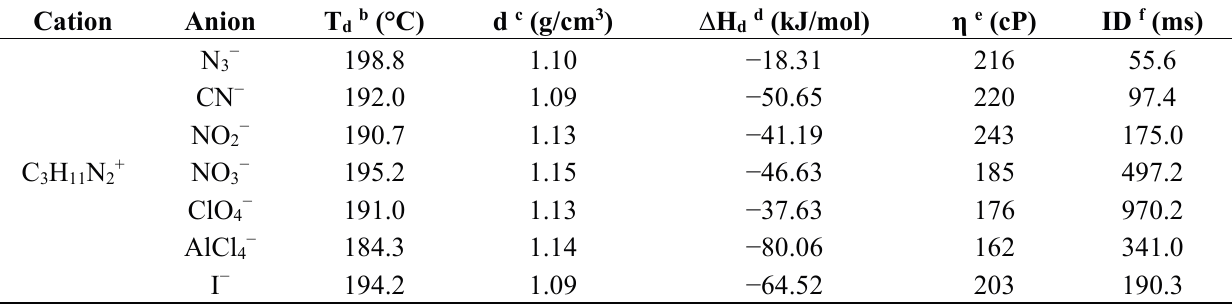
Figure 3. 1 H-NMR spectrum ( a ) and GC-mass data ( b ) of 1-ethyl-4-methyl-1,2,4-triazolium iodide, [EMT] + [I] − . Table 1. Physical and chemical properties of the mixture solution with N , N , N -trimethylhydrazinium salts and 2-hydroxyethylhydrazine a